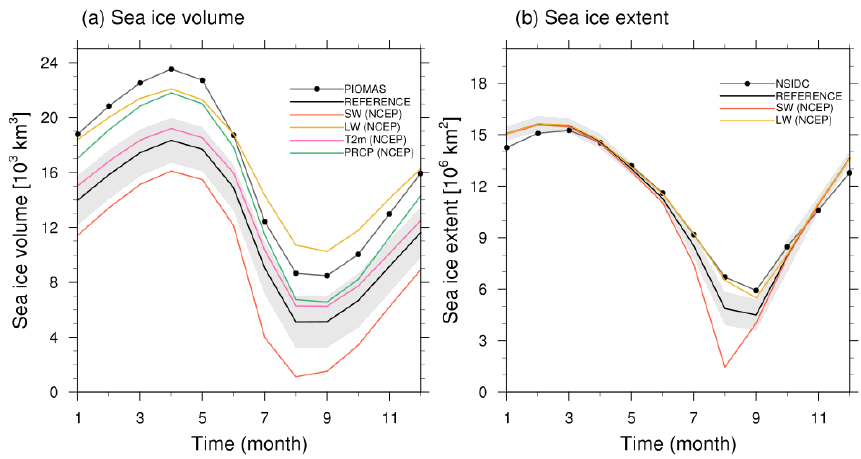
Figure 3. ( a ) Sea ice volume and ( b ) sea ice extent averaged from 1991 to 2014 in the Arctic region for different simulations and data sets. Shading indicates one standard deviation from REFERENCE. Table 3. Mean and normalized standard deviations of summer (JJAS) and winter (ONDJFMAM) sea ice volume and sea ice